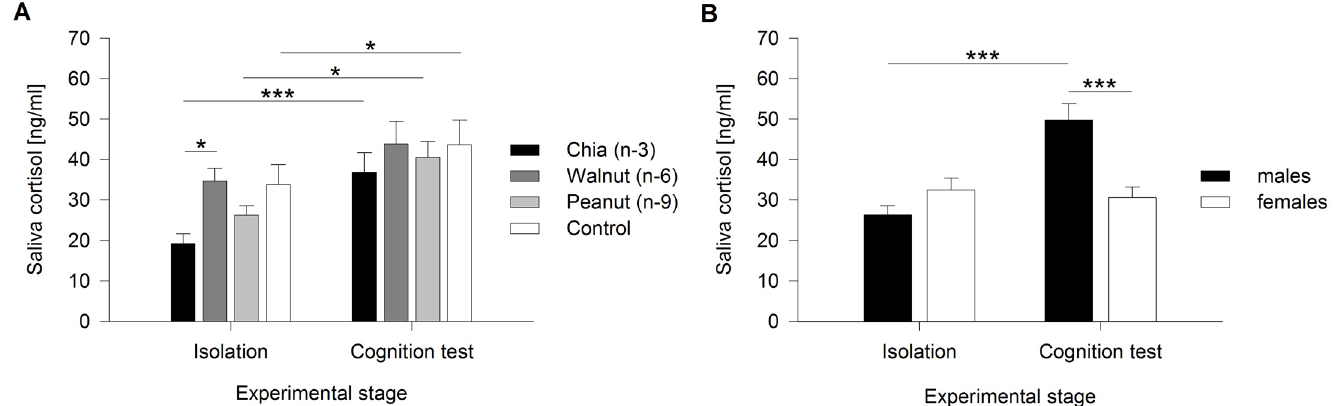
Fig 3. Saliva cortisol concentrations throughout the isolation period and the cognition test. (A) Saliva cortisol [ng/ml] for single groups (both sexes combined) based on the significant interaction of ‘ group ’ and ‘ stage ’ . (B) Saliva cortisol [ng/ml] for the sexes (all four groups combined) based on the significant interaction of ‘ sex ’ and ‘ stage ’ . Values are means ± SEM. * p (cid:1) 0.05, ** p (cid:1) 0.01, *** p (cid:1) 0.001.